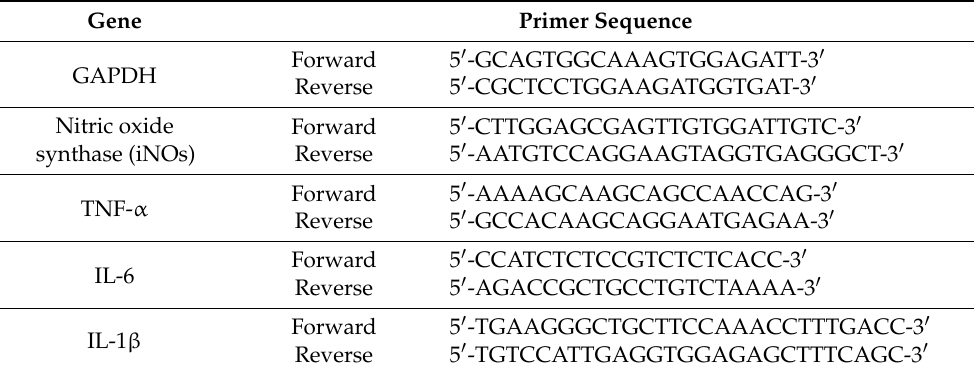
Table 1. Primer sequences of targeted genes and